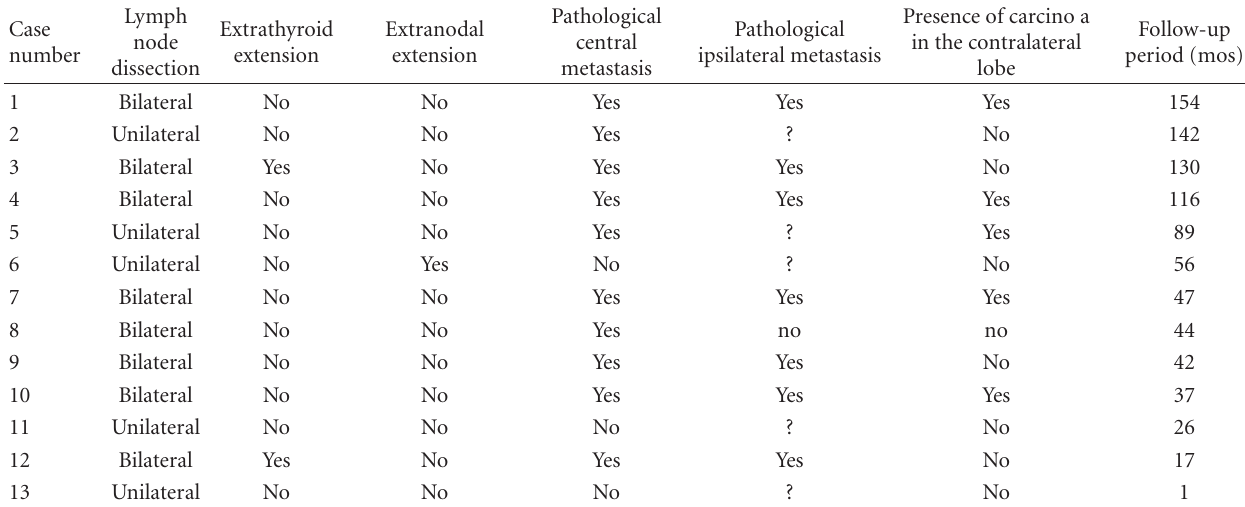
Table 2: Intraoperative and pathological findings of 13 patients with contralateral but not ipsilateral N1b.